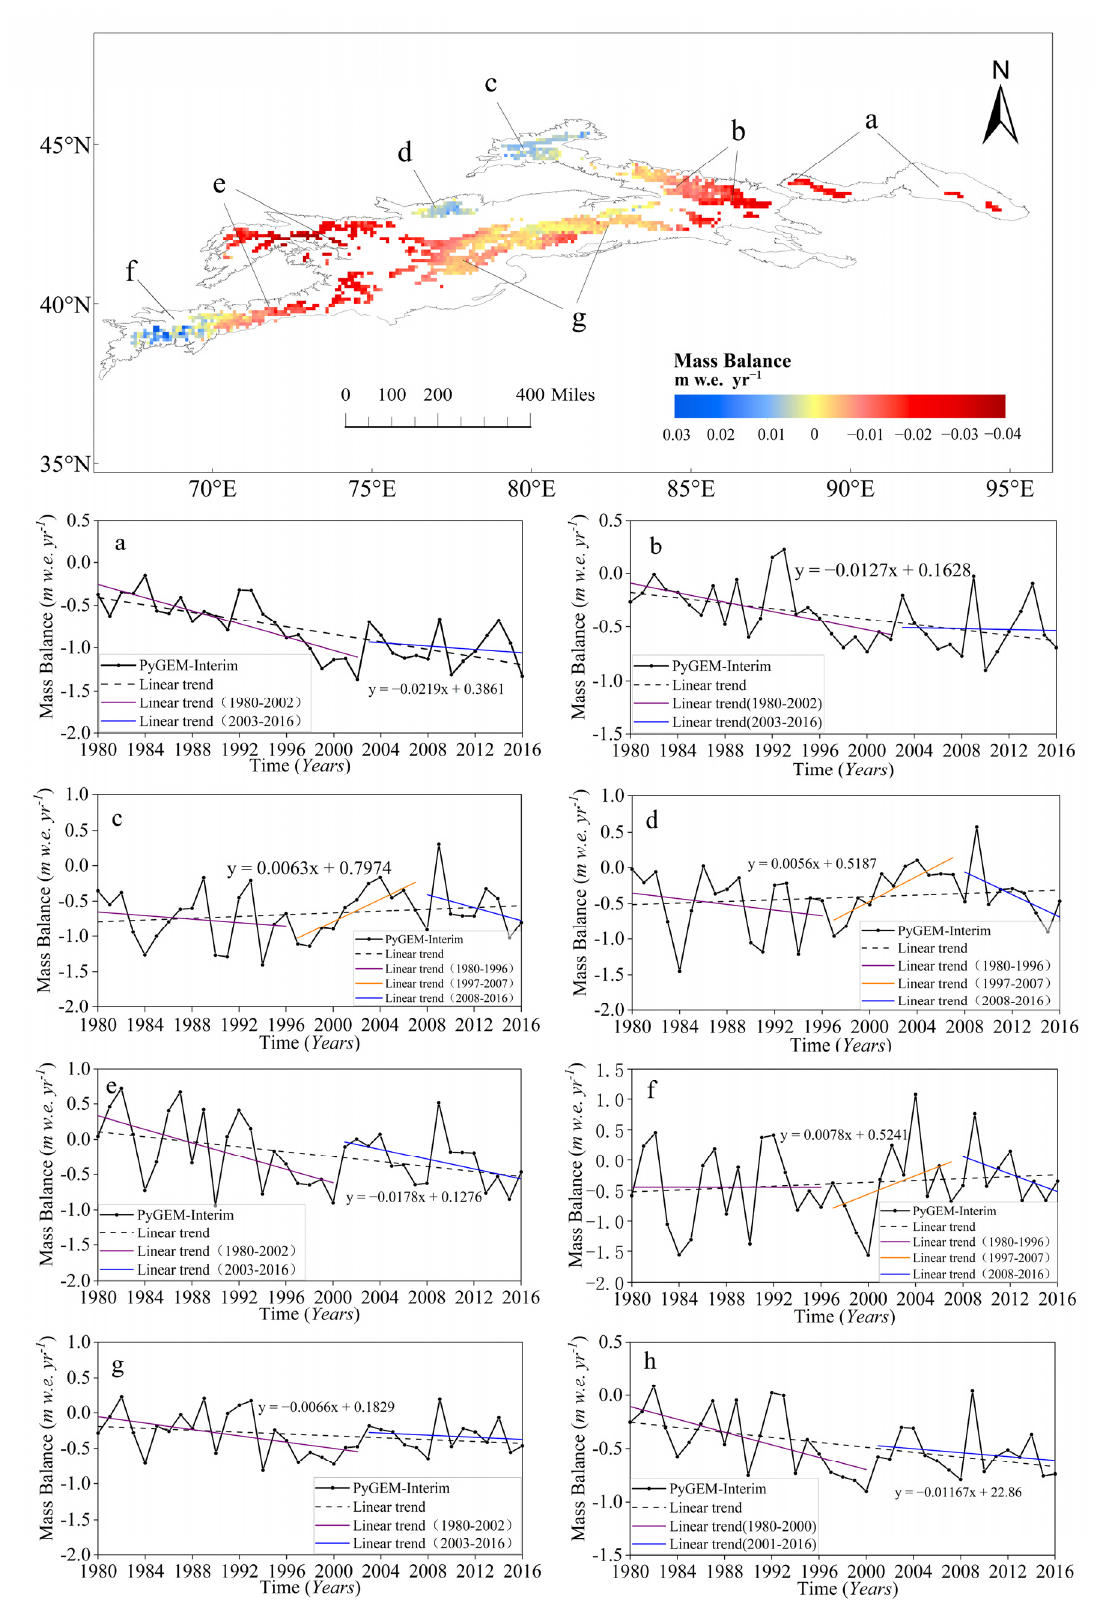
Figure 3. Spatial distribution ( top panel ) and temporal variations ( a – h ) in the mass balance of Tien Shan glaciers from 1980 to 2016. ( a ) East Tien Shan; ( b , c ) central and eastern, western in North Tien Shan; ( d , e , f ) northeast, central, southwest in West Tien Shan; ( g ) Central Tien Shan; and ( h ) total.